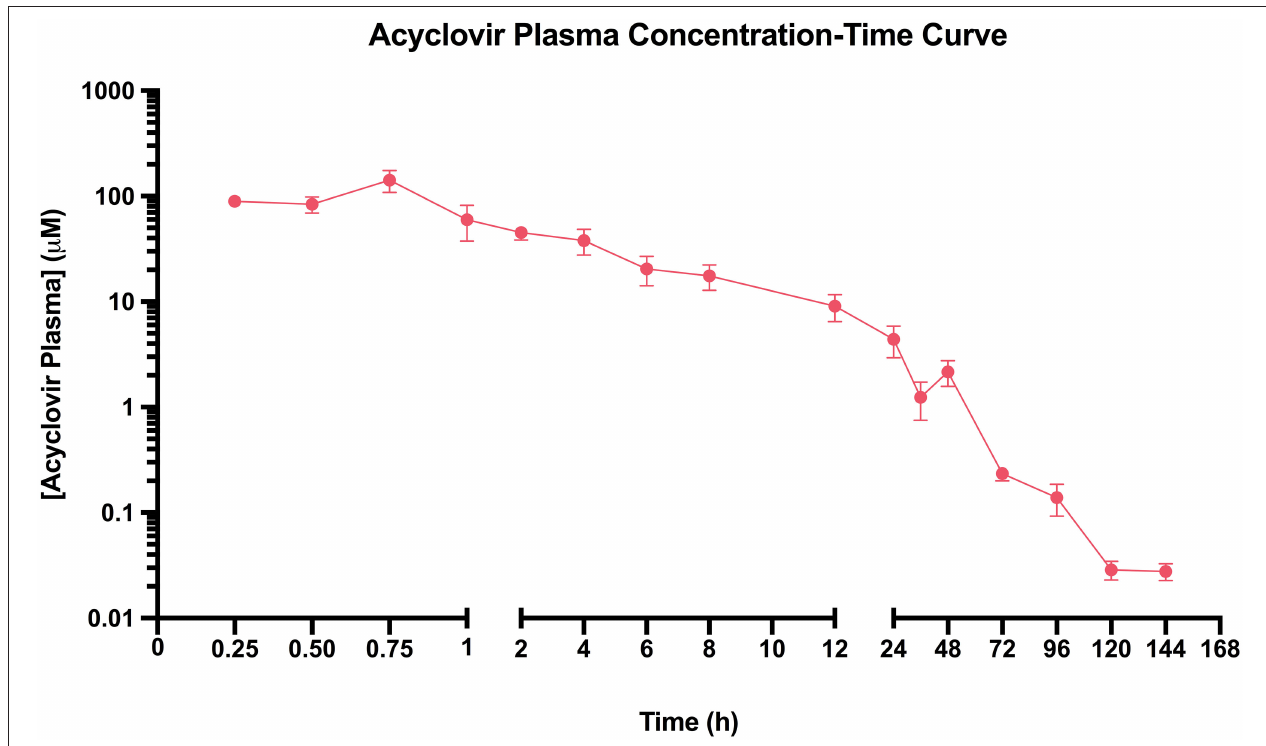
FIGURE 3 | Acyclovir Plasma Concentration-Time Curve. Koi fingerlings received a single 10 mg/kg acyclovir intracoelomic dose. Blood from the caudal vein was collected after euthanasia at different timepoints from 15min to 6 days after drug administration. The solid pink dots represent the mean acyclovir plasma concentration at each time-point, with standard error of the mean plotted. Results indicate that an acyclovir peak plasma concentration of 141 µ M is obtained in 0.75h, with a half-life of